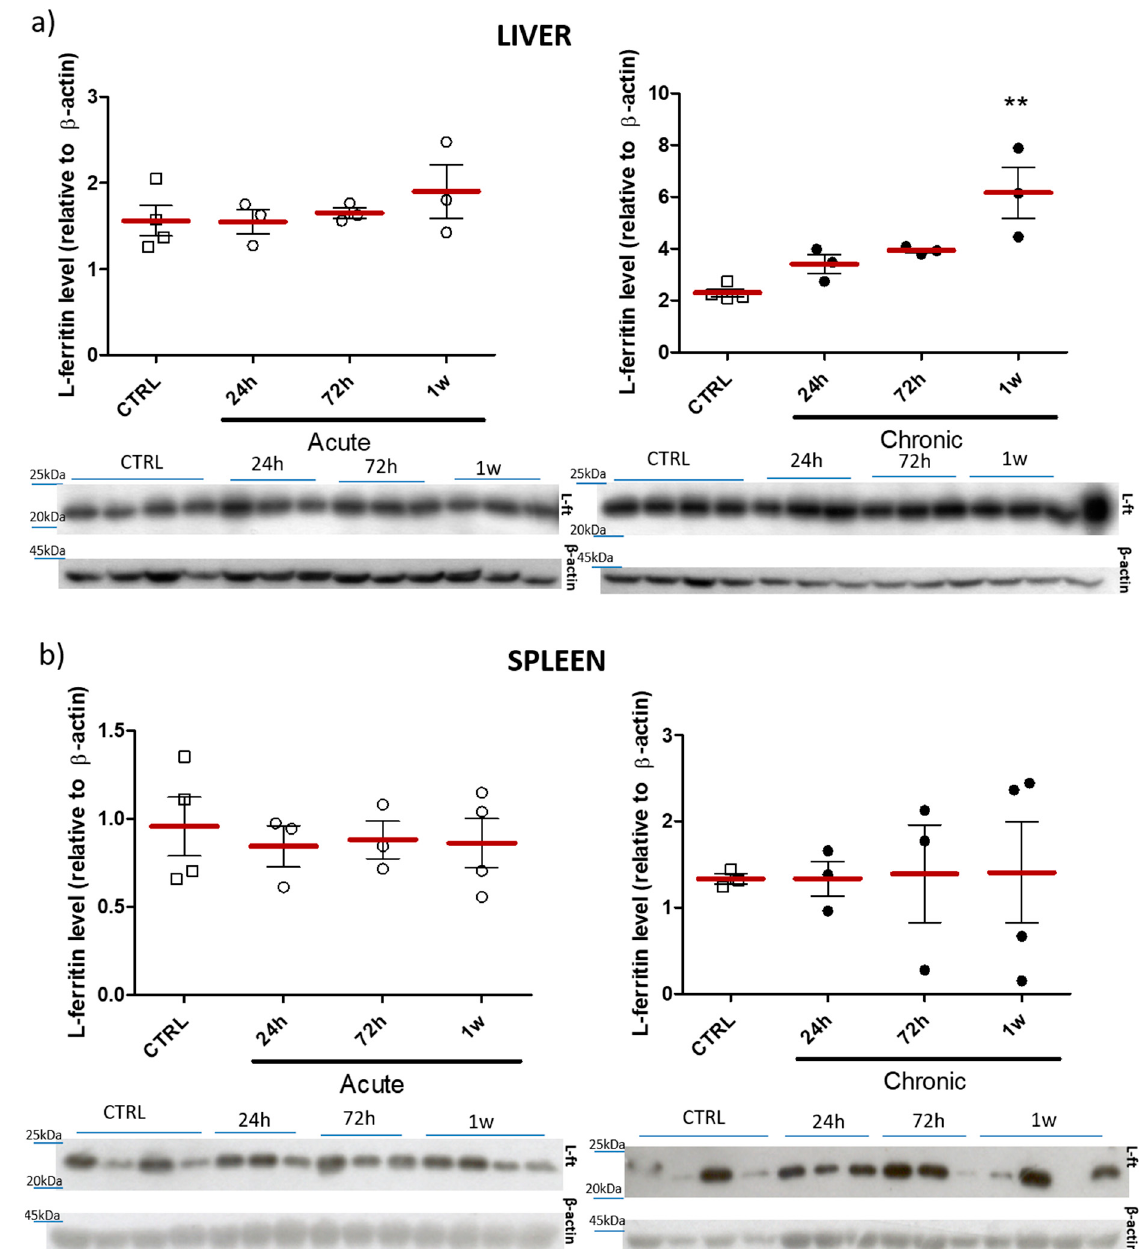
Figure 14. Western blot densitometric analyses of the levels of L-ferritin subunit in the liver ( a ) and spleen ( b ). Representative immunoblots are shown below plots. Results obtained at different time-points (24 h, 72 h or 1 w) after multiple intra-gastric administration of ZnO:Fe 3+,2+ nanoparticles in acute and chronic simulation modes. Data presented as mean (±SEM) for control ( n = 4) vs. experimental groups (Acute 24 h n = 3; Chronic 24 h n = 3; Acute 72 h n = 3; Chronic 72 h n = 3; Acute 1 w n = 3 for a / n = 4 for b ; Chronic 1 w n = 3 for a / n = 4 for b ). Statistically significant differences of ** p ≤ 0.01 were accordingly indicated. Range presented as squares for CTRL, open circles for acute model and filled circles for chronic model in experimental groups.